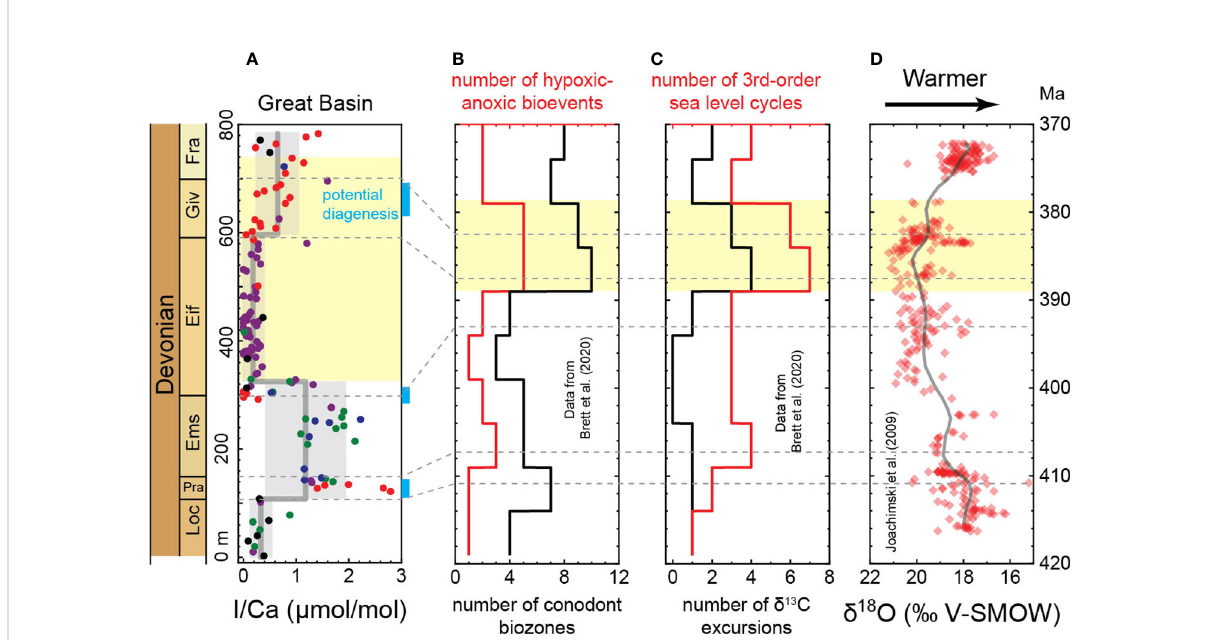
FIGURE 5 I/Ca ratios of the Great Basin section and compiled Devonian environmental and biotic parameters. (A) Stratigraphic trends of I/Ca are subdivided into four intervals; the straight gray lines represent averages of I/Ca within each interval, and the gray boxes show the ranges of one standard deviation. (B, C) Numbers of conodont biozones, hypoxic/anoxic-related bioevents, carbon isotope excursions, global sea level changes within Devonian time bins of 5 Myr durations. Data are modi fi ed from Tables 2 and 4 of Brett et al. (2020) and we used the subdivided zonation for conodont zones here. (D) Global records of oxygen isotopes of conodont apatite (Joachimski et al., 2009). The gray curve in (D) represents loc fi t regression of Joachimski et al. (2009). The gray dashed lines correlate the Great Basin stage boundaries to those of the compiled datasets. The yellow boxes highlight the intervals of highest volatility identi fi ed by Brett et al. (2020). Color code for lithological groups: grainstone (red), packstone (blue), wackestone (green), lime mudstone (purple), unassigned